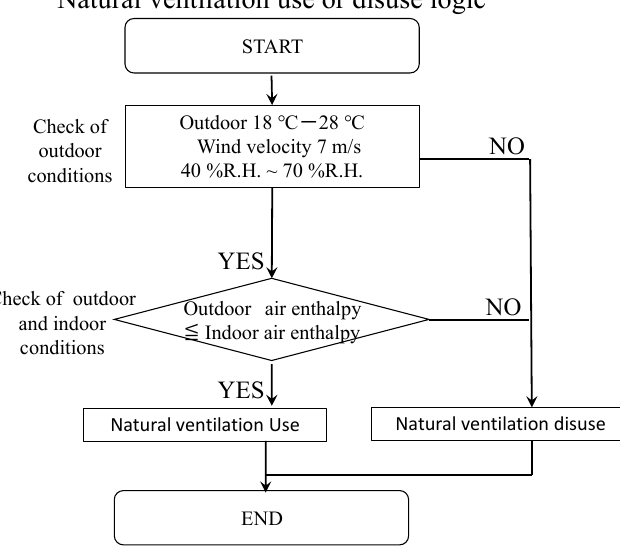
Figure 7. Description of the control strategies for natural ventilation. 187